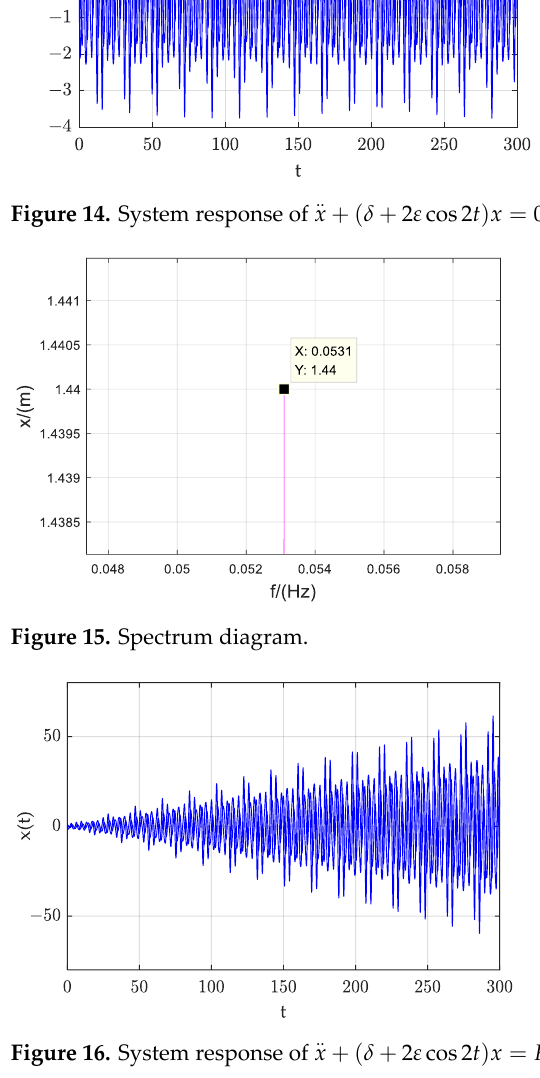
Figure 16. System response of